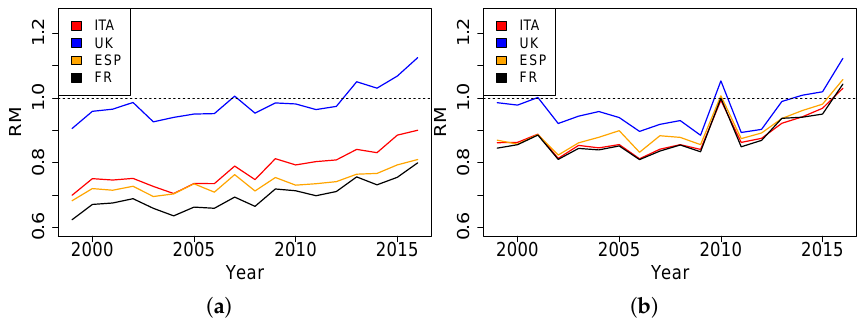
Figure 4. ( a ) RM for female population, ( b ) RM for male